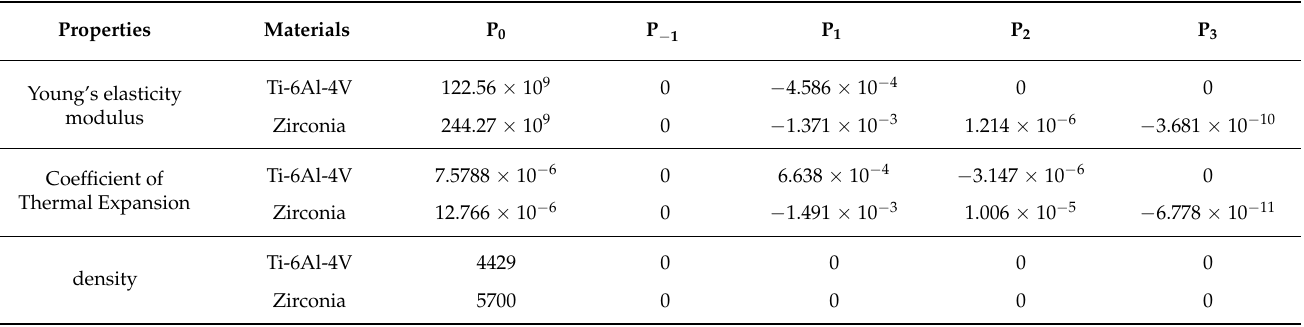
Table 3. TD constants of metal and ceramic phases.